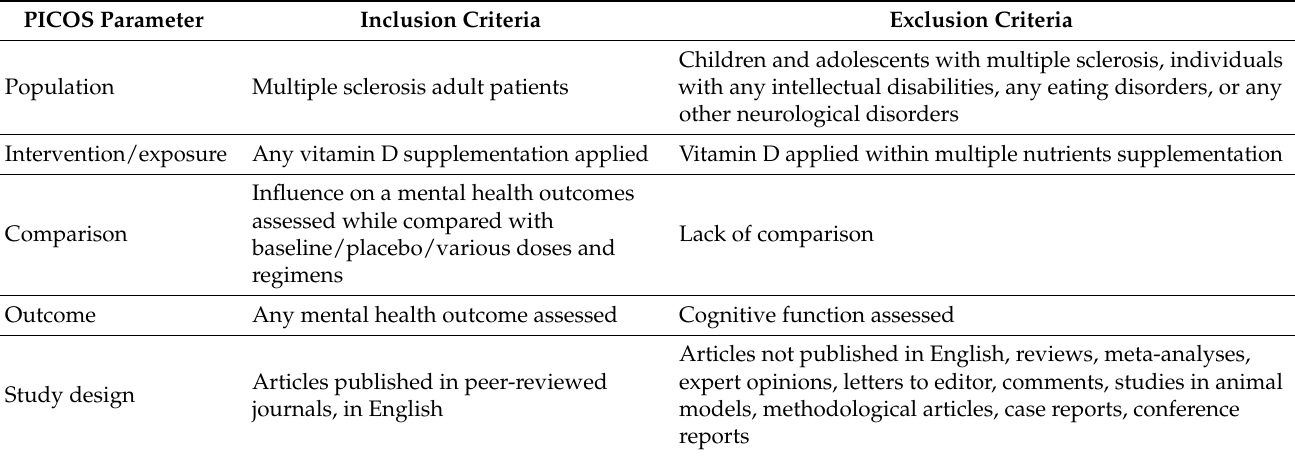
Table 1. The summary of the patient, intervention/exposure, comparator, outcome, and study design (PICOS) criteria for inclusion and exclusion of studies in a systematic